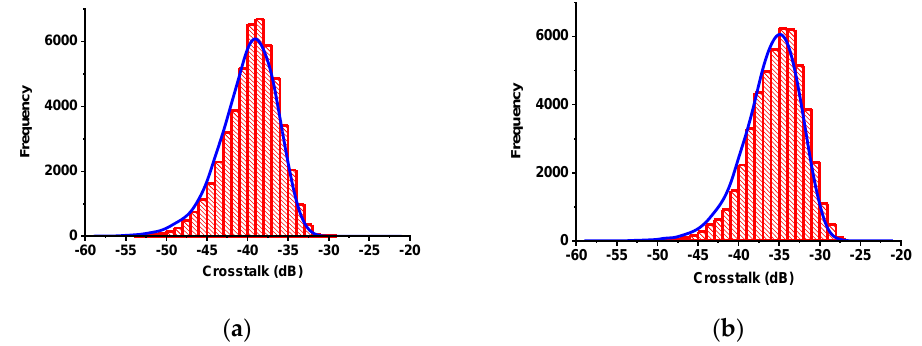
Figure 16. Crosstalk statistical distribution functions for 1540 m long fiber: ( a ) shipping reel; ( b ) measurement reel. Blue lines: modeled χ 2 -distributions.